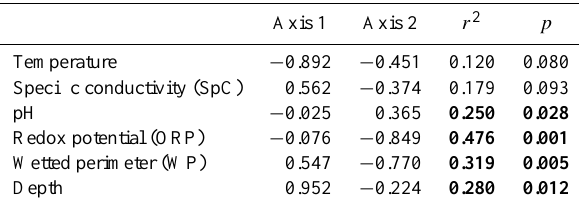
Table 3. Vector lengths of environmental and habitat variables to the ordination axes and variable correlation to the ordination. Statistically-significant correlations are in bold. Axis 1 Axis 2 r 2